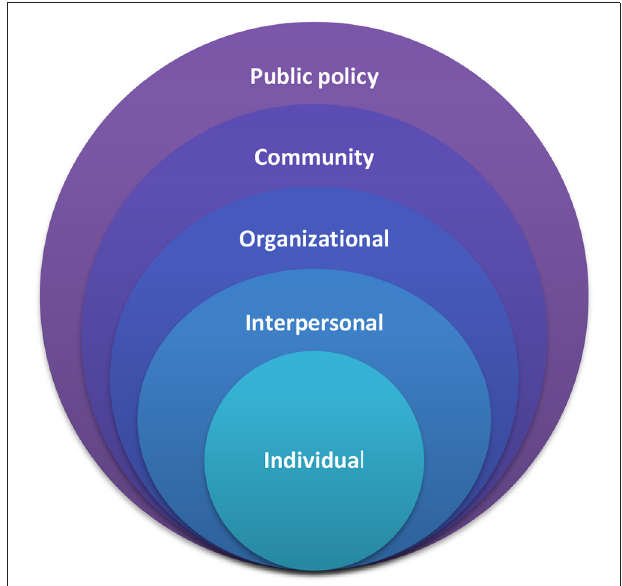
FIGURE 1 | The socio-ecological model